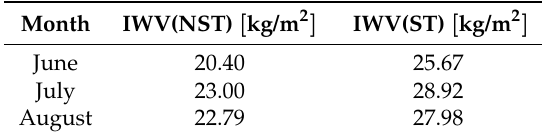
Table 2. Monthly IWV averages for the days with a storm (ST) and without a storm (NST).